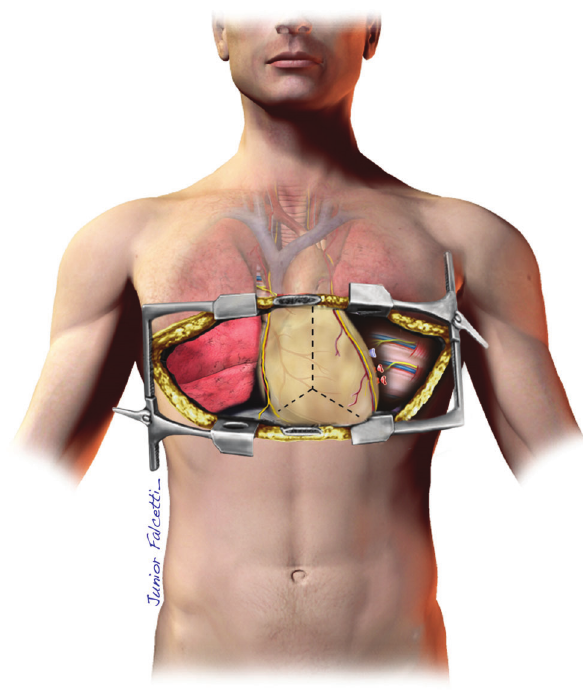
Figure 1 - Left view of the chest cavity from the ‘‘ clamshell ’’ incision, without retraction of the pericardium. It is not possible to visualize the left atrium or the pulmonary veins.